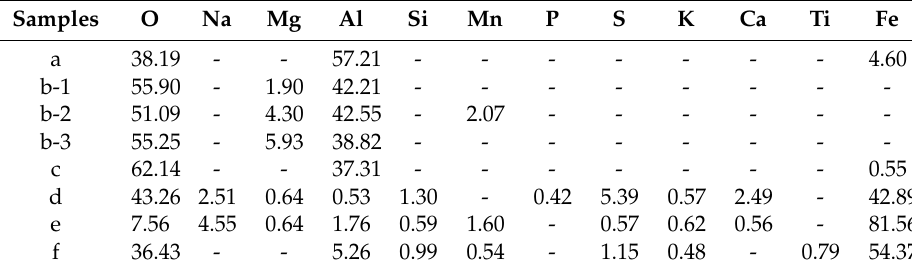
Figure 4. Morphology of non-metallic inclusions. ( a , b ) normal surface; ( c – f ) depression surface. Table 2. Chemical compositions of the inclusions (a–f) (wt.%).